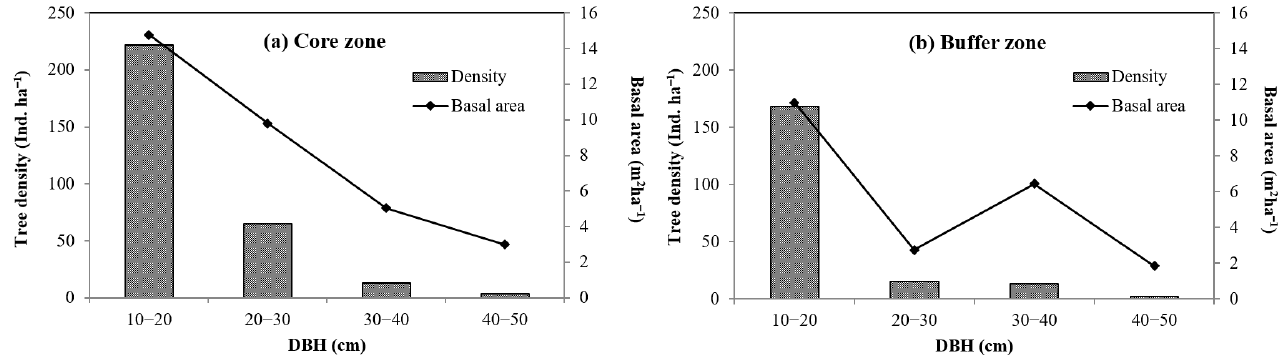
Figure 4. Contribution of tree stand density and basal area based on diameter class distributions in the core ( a ) and buffer ( b ) zones in Minkong Community Forest Reserve, Nagaland, India.